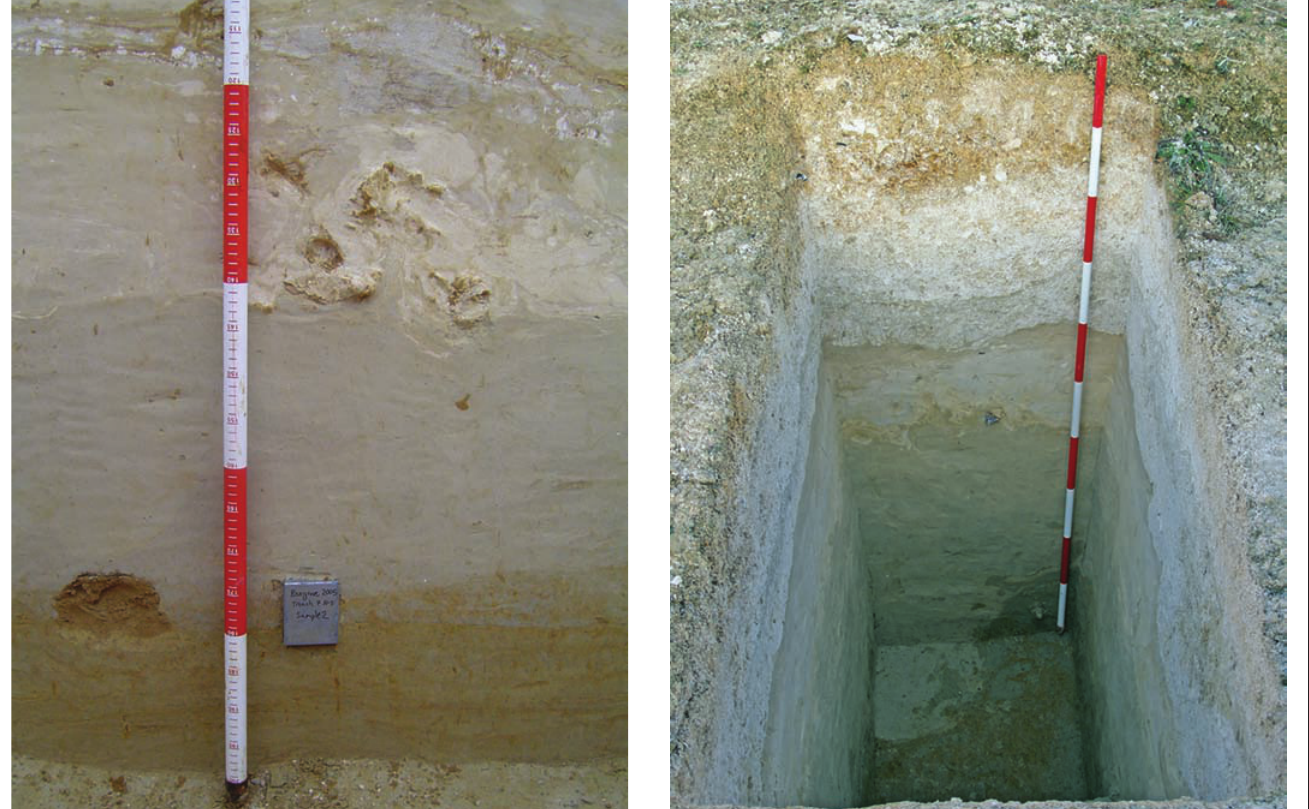
Figure 9 Recent test excavations at Q1B, left in the old main area and right at the northern margin of the new